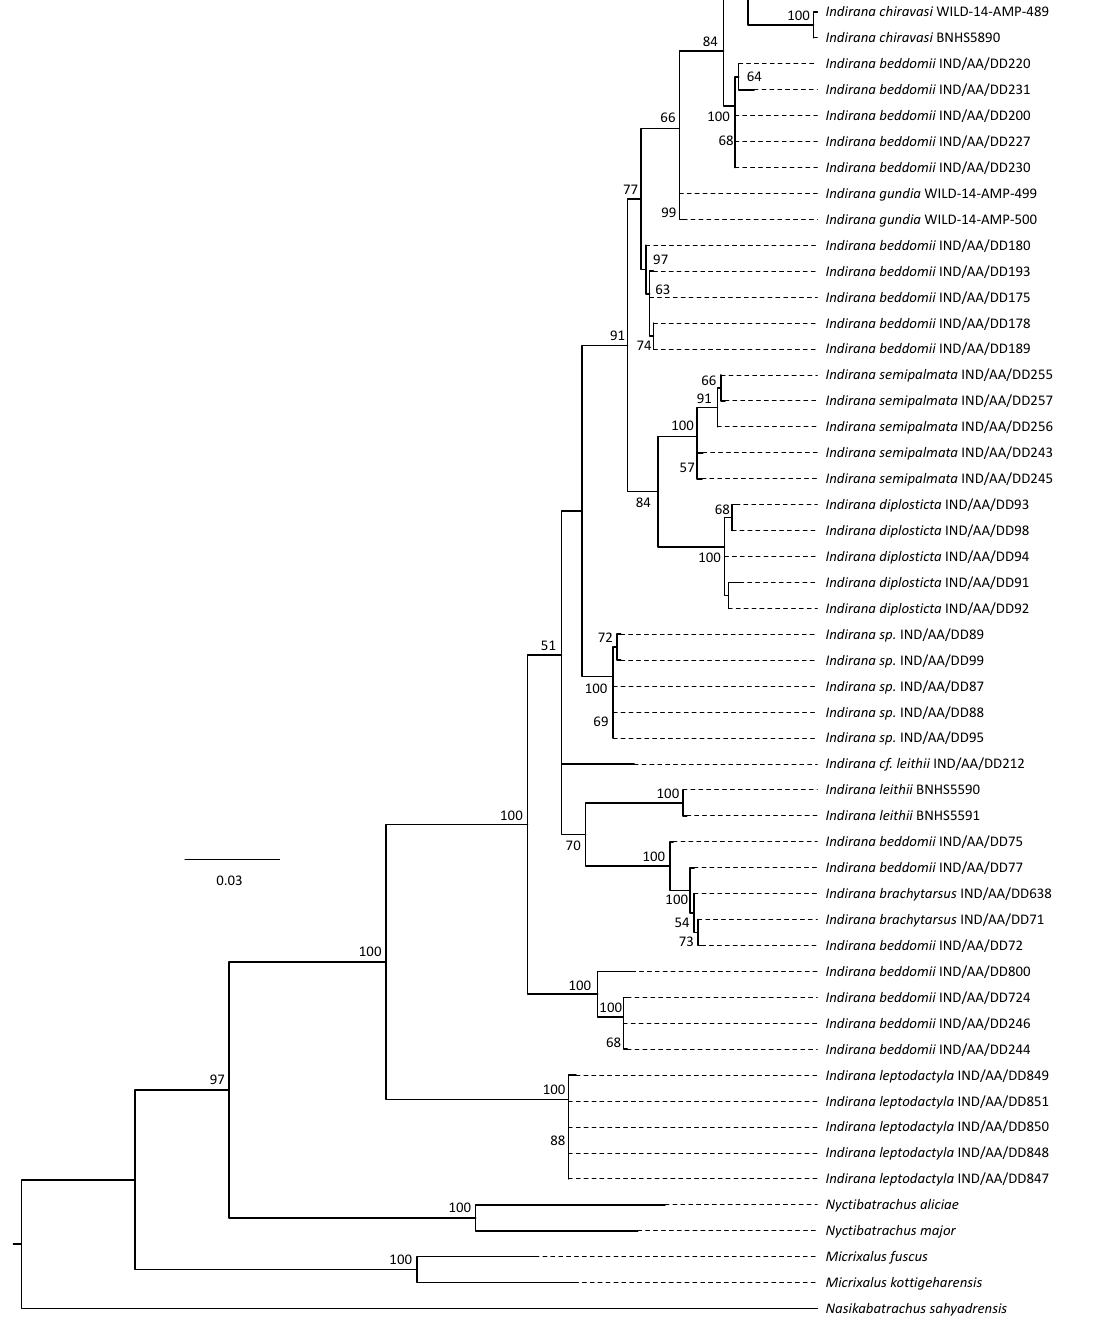
Figure 3. Maximum likelihood tree based on GTR+G+I (BIC = 10429.89, lnL = -4596.32, I = 0.32, G = 0.58) nucleotide substitution model for combined matrix of 12SrRNA, 16s rRNA and rhodopsin gene sequences. Values along the nodes are percent bootstraps for 1000 iterations. Nasikabatrachus sahyadrensis is used as an outgroup.